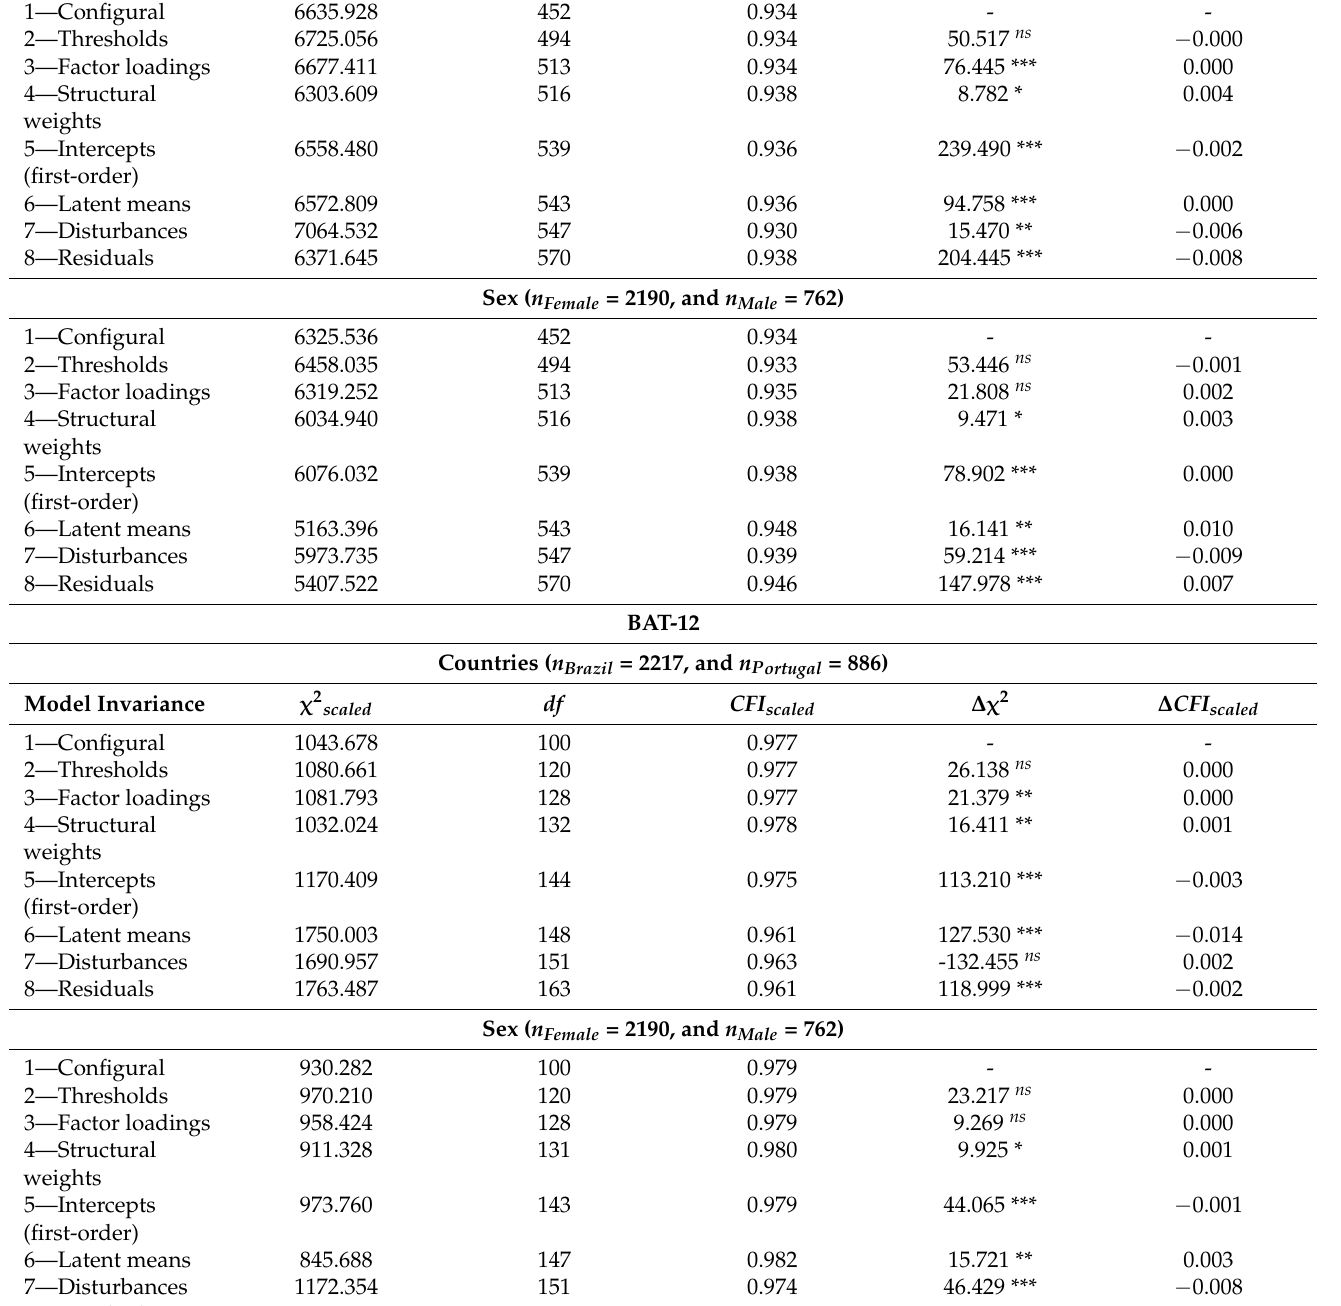
Table 5. Measurement Invariance (for BAT-23 and BAT-12) Between Countries, and Sex. BAT-23 Countries ( n Brazil = 2217, and n Portugal =